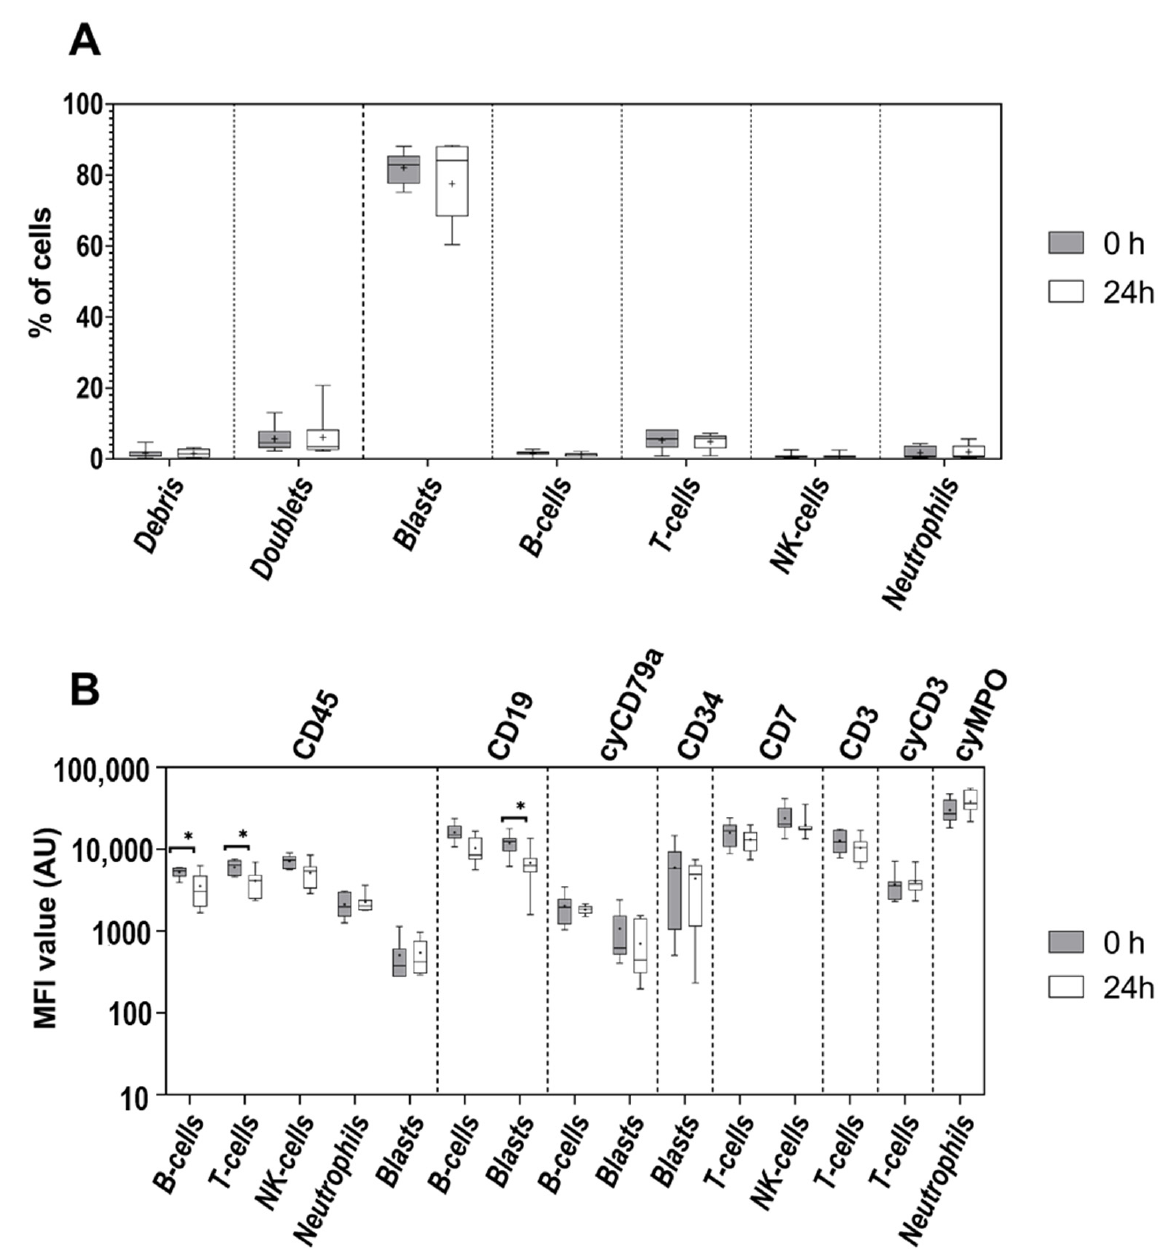
Figure 2. Comparison of the relative distribution of leukemic blasts of BCP-ALL patients ( n = 7) and normal cell populations identifiable with the ALOT antibody combination ( A ) and MFI expression levels of the corresponding markers ( B ) evaluated on normal and leukemic cell populations from BCP-ALL patients. Dark boxes represent samples acquired fresh, and light boxes represent those acquired after 24-h storage at RT. The median and mean MFI values are indicated inside the boxes with a line and “+” sign, respectively. The boxes spread between first and third quartiles of the obtained MFI values and whiskers span between minimal and maximal values. Asterisks indicate significant differences between both time points ( p < 0.05).